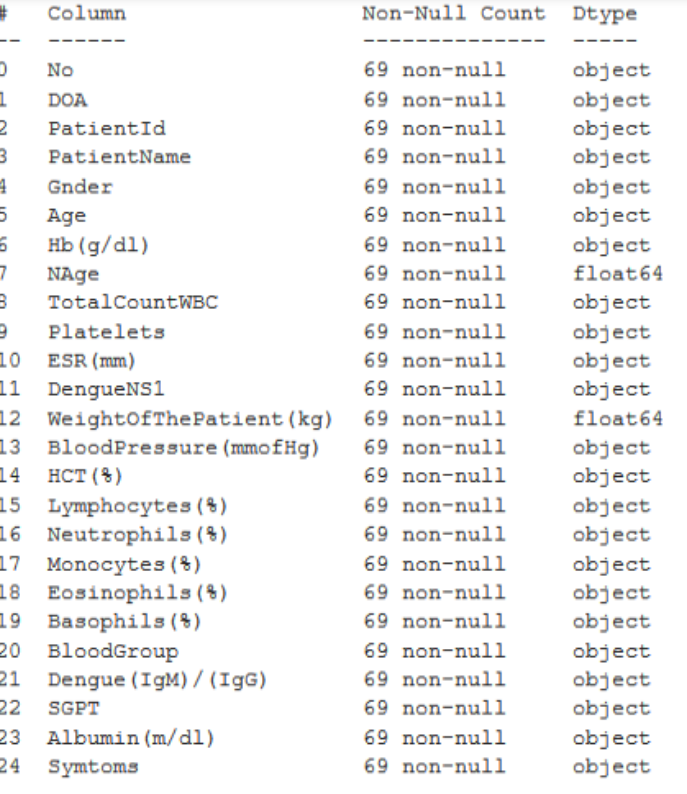
Figure 3. Showing attributes of the Shishu Hospital dataset.